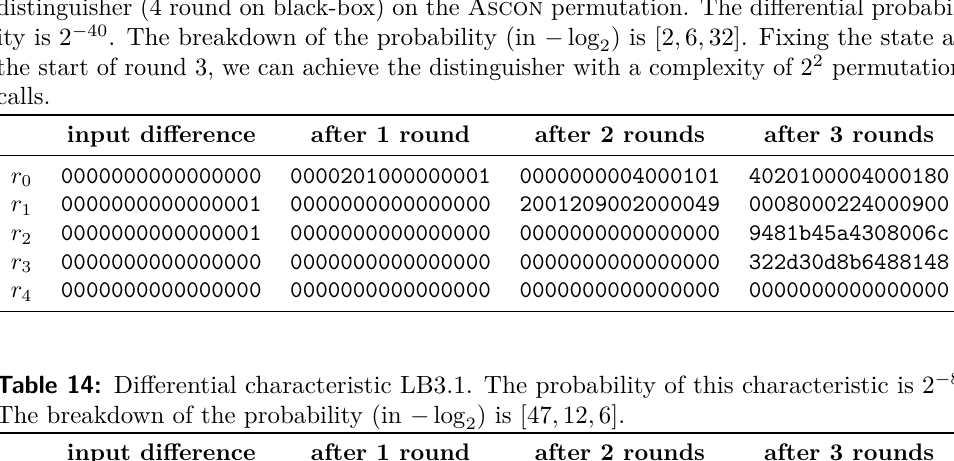
) is [2 , 6 , 32]. Fixing the state at 2